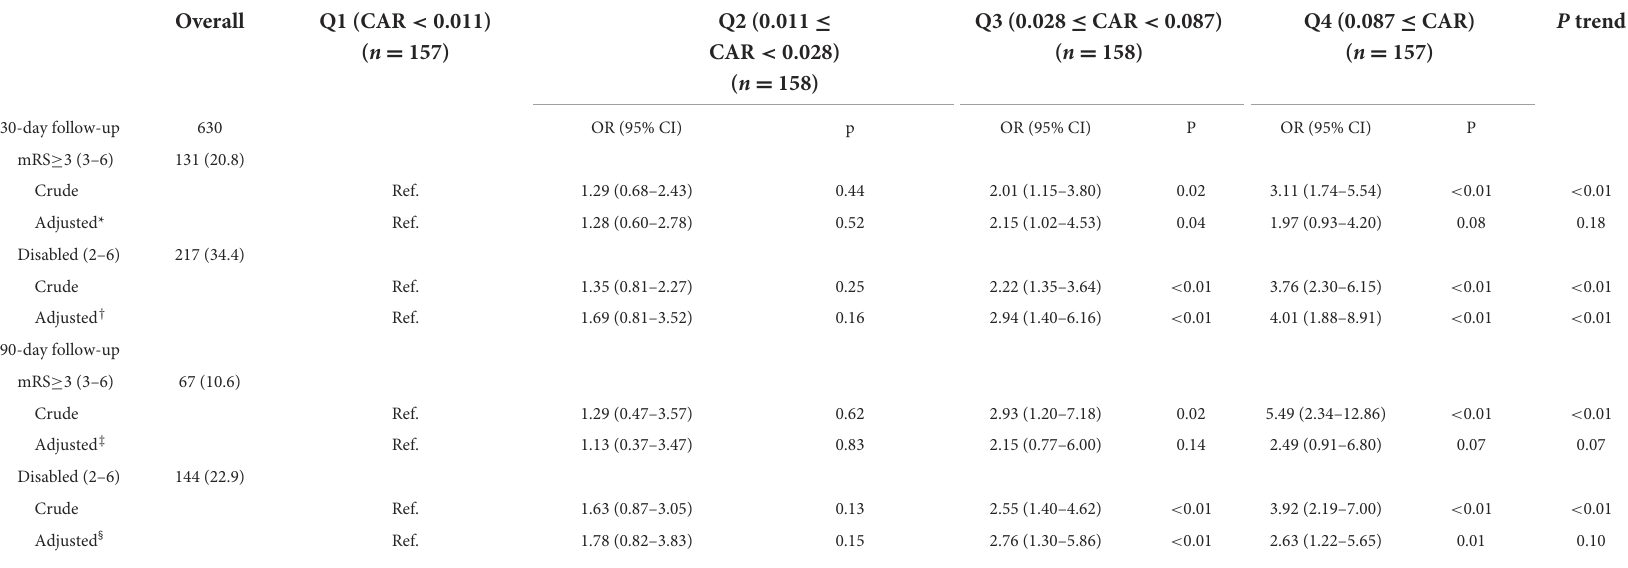
TABLE 3 Risks of adverse clinical outcomes stratified by